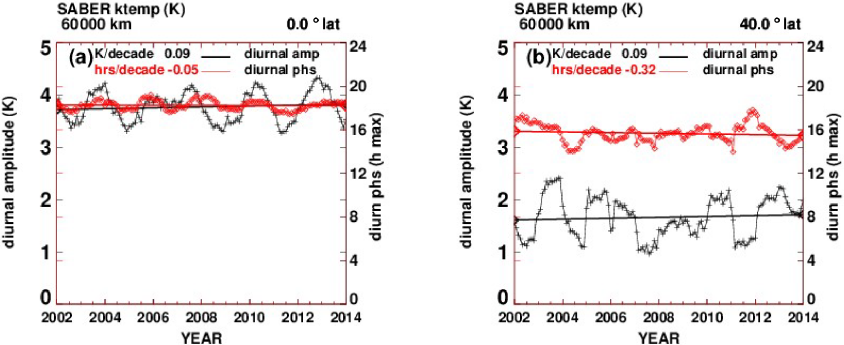
Figure A3. (a) Temperature tidal diurnal amplitudes and phases at 60km and the Equator. On the left axis scale, black line: tidal diurnal amplitude (K). On the right axis scale, red line: diurnal phase (h of maximum value). (b) As in (a) but at 40 ◦ N latitude.